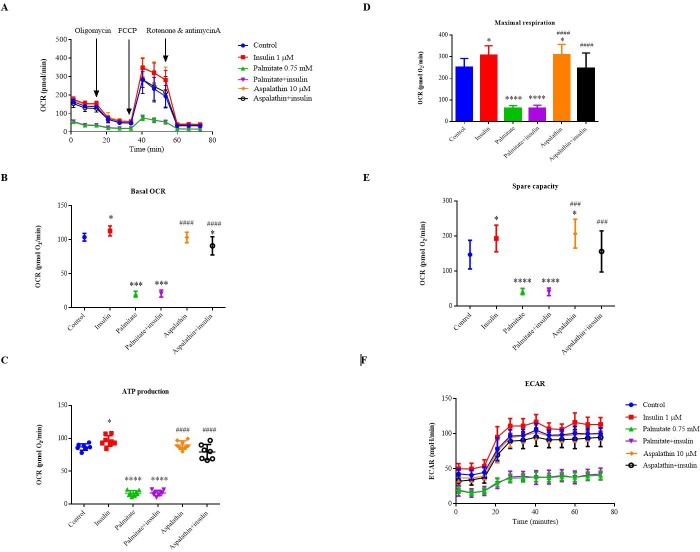
The effects of aspalathin on mitochondrial respiration in insulin-resistant C3A liver cells.The graph shows oxygen consumption rate of all treatments (OCR) (A), individual parameters for basal respiration (B), ATP production (C), maximal respiration (D), and spare respiratory capacity (E), and extracellular acidification rates (F). Oxygen consumption rate was measured under basal conditions followed by the sequential injection of oligomycin (1 μM), FCCP (0.75 μM), as well as rotenone (0.5 μM) & antimycin A (0.5 μM), as indicated. Each data point represents an OCR measurement. Data are expressed as means ± SEM, n = 2 independent experiments. **** p < 0.0001 versus normal (no insulin) control, #### p < 0.0001 versus palmitate control.